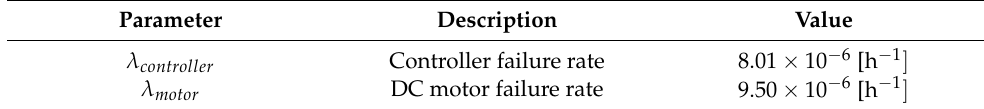
Figure 8. Examples of system load-following operations. Table 3. Parameters for hardware stochastic